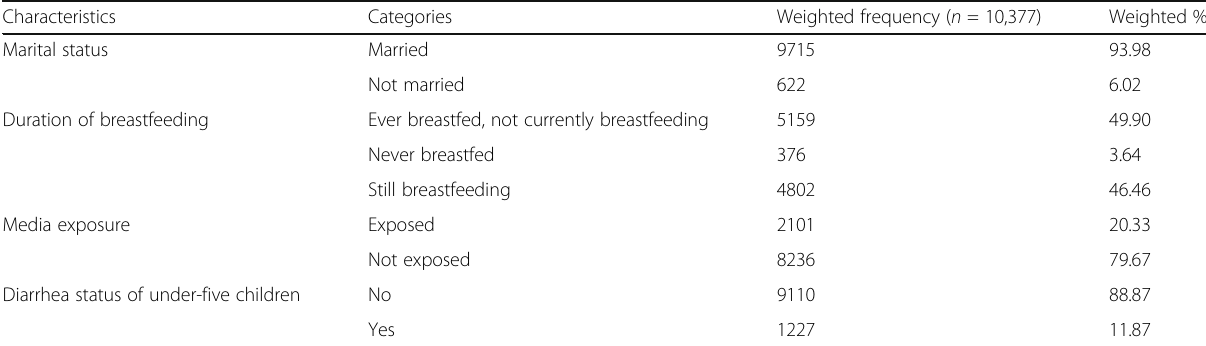
Table 1 Socio-demographic characteristics of mothers, parents, and children under 5 years of age, DHS 2016, Ethiopia (Continued) Characteristics